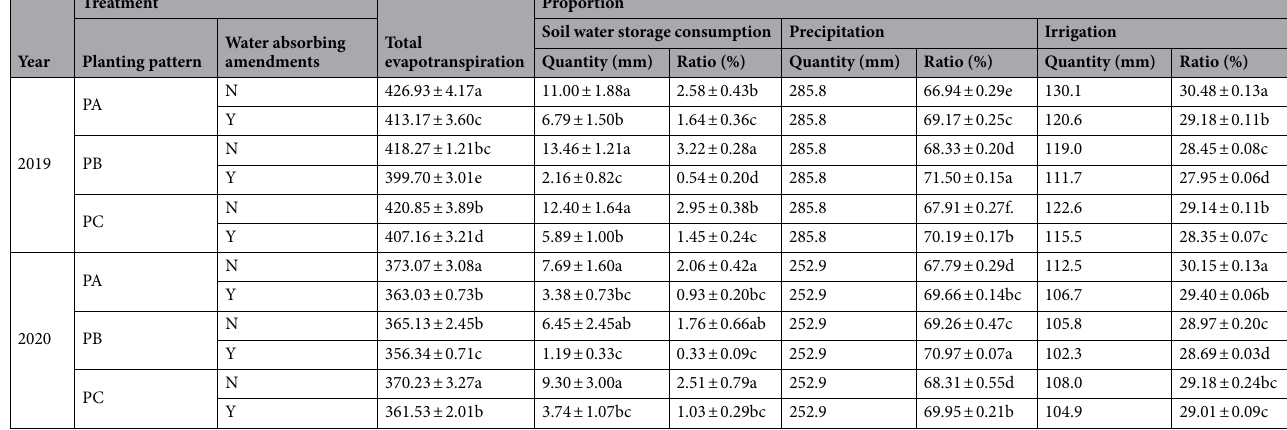
Table 6. Evapotranspiration and its proportion as affected by planting patterns and super absorbent polymers in 2019–2020. Different letters of different treatments in the same year showed significant differences (P < 0.05), and the following numbers showed the standard deviation of the data.